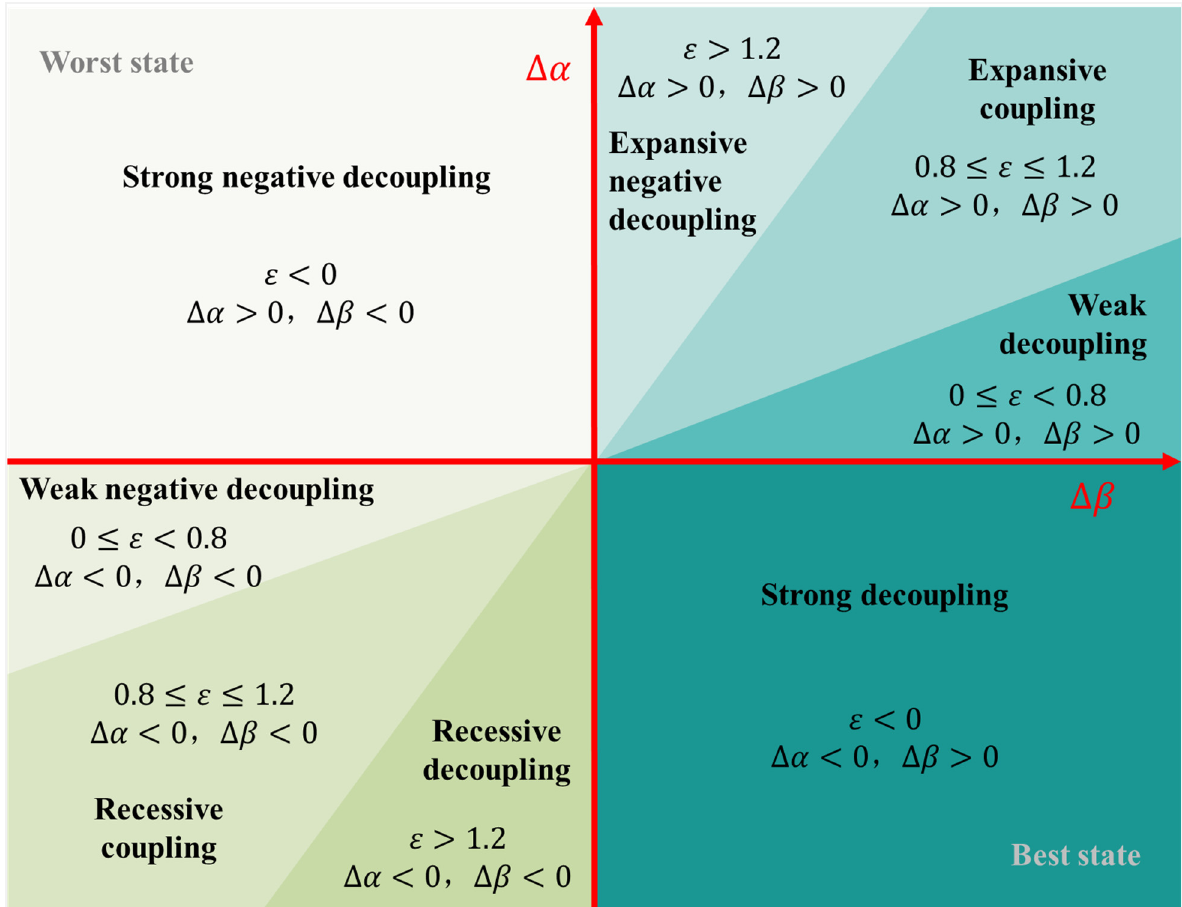
Figure 5. Decoupling types and Decoupling indicator ranges.